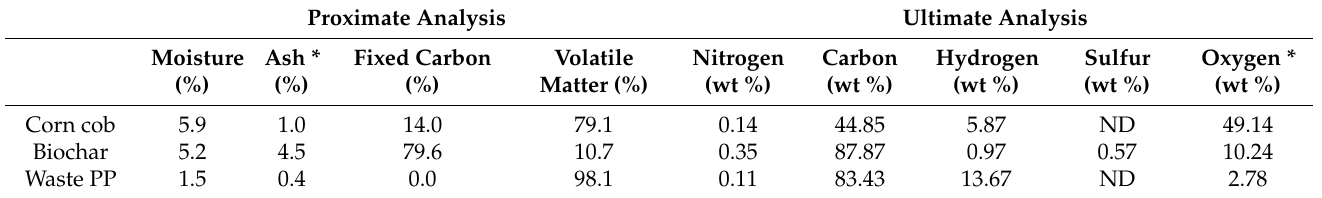
Table 1. Proximate and ultimate analysis of corn cob, biochar, and waste